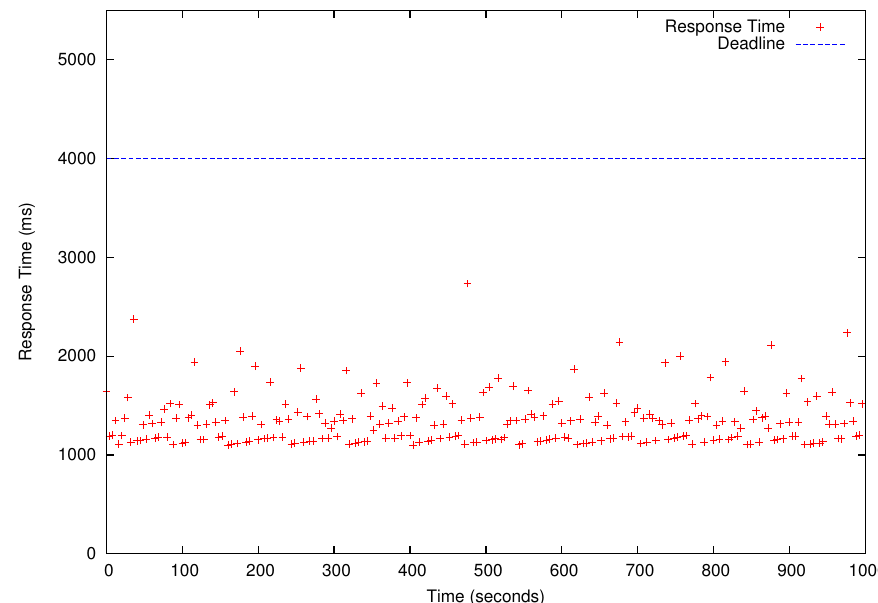
Figure 10. Response Times of Matrix Multiplication (MM) Jobs. The blue horizontal bar is the deadline (4 s). Each red dot represents the response time of one periodic MM job.